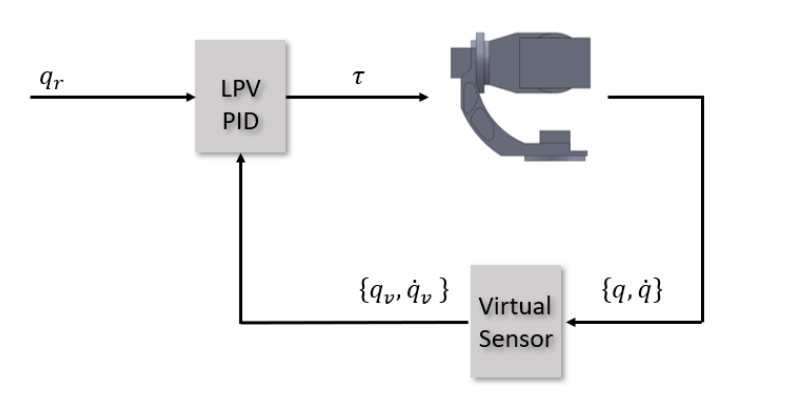
Figure 10. Closed-loop control system for the three-axis gimbal with virtual sensor